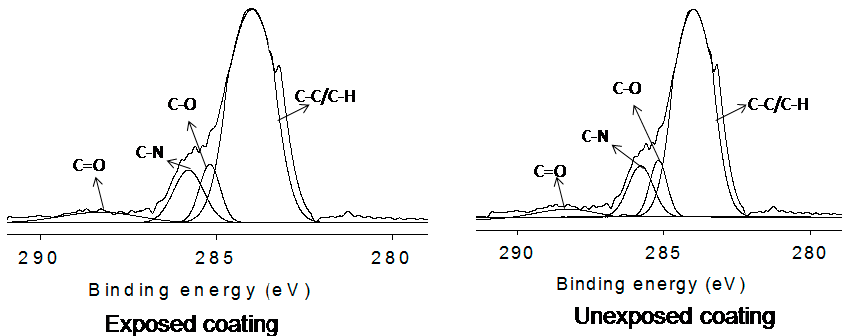
Figure 5. Typical deconvoluted XPS scan of coating.